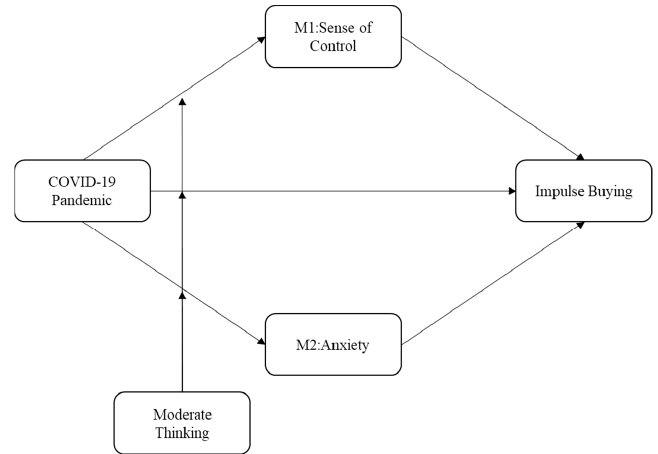
Figure 1. Conceptual